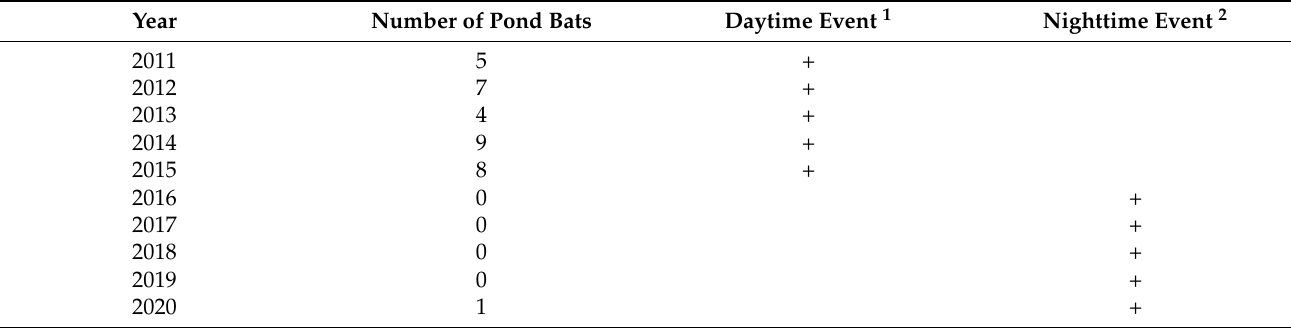
Table 3. An overview of the number of individual pond bats ( Myotis dasycneme ) between 2011 and 2020 during the autumn swarming season count on-site in October [64]. This suggests there is a correlation between the daytime and nighttime light, sound, and music events organised on-site, or on the adjacent river, and a reduction in pond bat numbers. Source: authors’